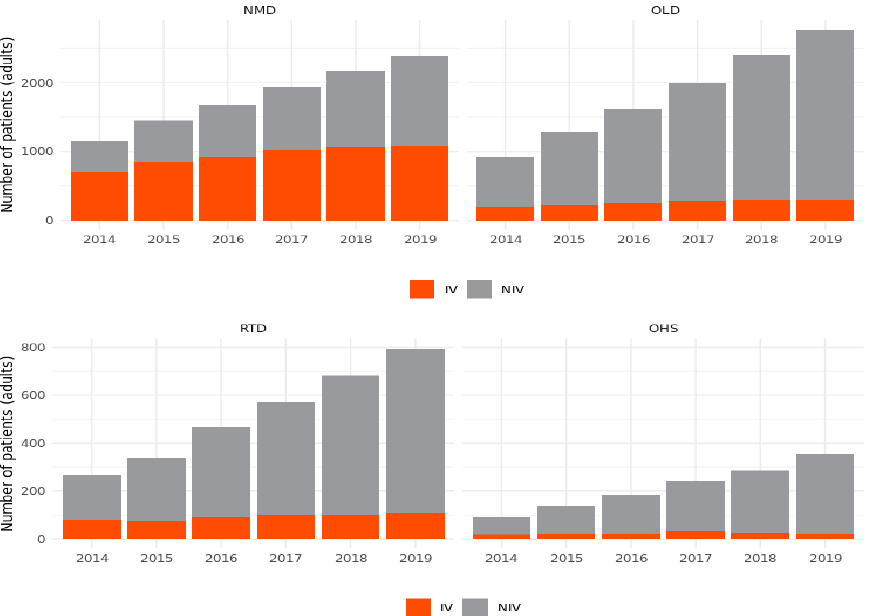
Figure 7. Number of mechanically ventilated patients (adults) acc. to condition and the method of ventilation in the years 2014–2019 . ventilation in the years